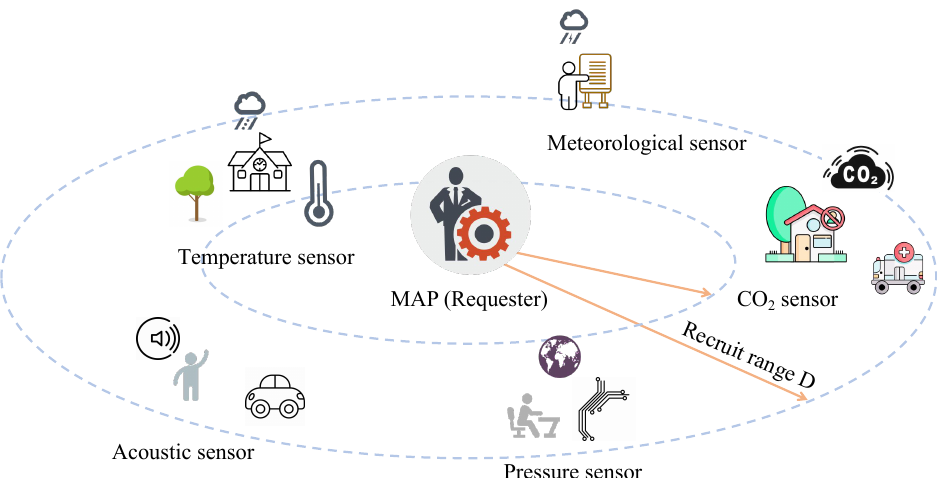
Figure 1. Spatial-temporal value of information in a crowdsensing